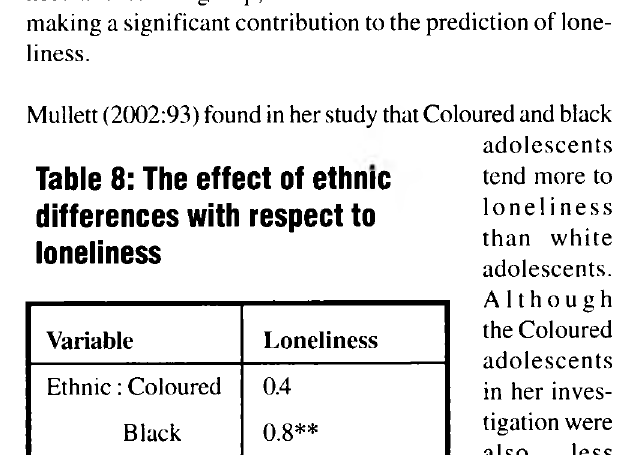
Table 8: The effect of ethnic differences with respect to